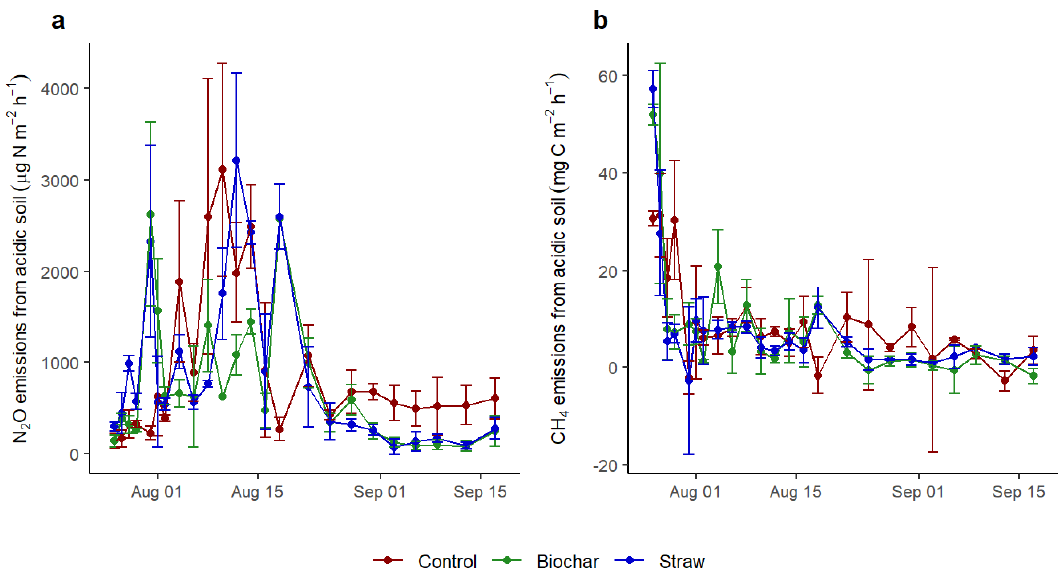
Figure 2. Temporal dynamics of the ( a ) N 2 O and ( b ) CH 4 emissions from arable acidic soil following application of maize straw and corn biochar throughout the entire sampling time (July 2020–September 2020) of the outdoor mesocosm experiment. The vertical bars indicate the standard error of the mean (n = 3).